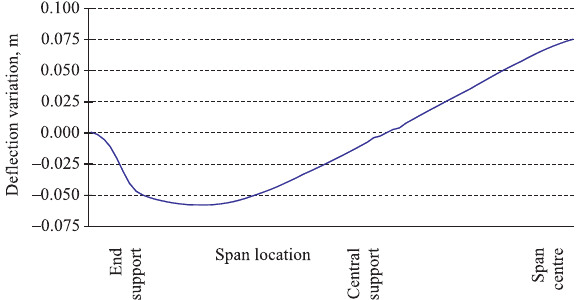
Fig. 18. The variation of deflection of box girder under dead load after cracking of